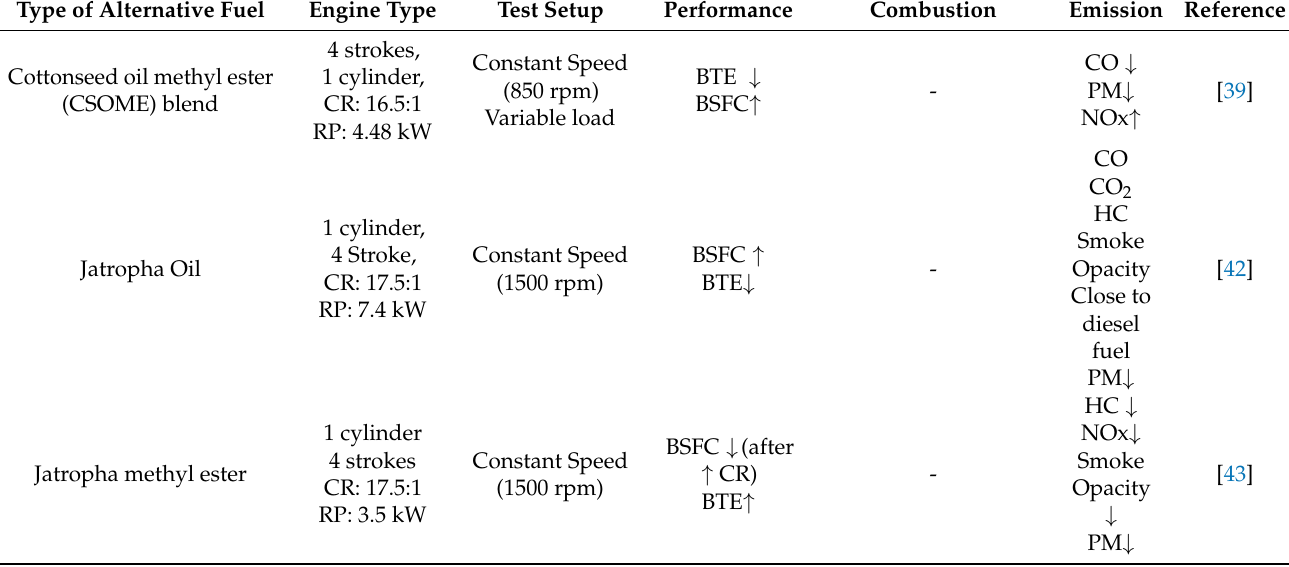
Table 1. Summary of the experimental works on alternative fuels that run on CI